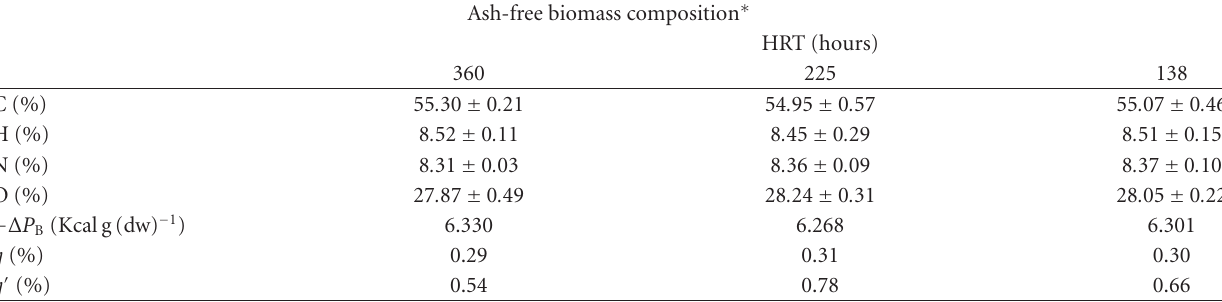
Table 2: Elemental biomass composition and heat of combustion of ash-free biomasses of R. palustris 42OL grown under SCR, at three di ff erent HRTs. The conversion e ffi ciencies ( η and η (cid:4) ) have been reported as well. Cells were harvested when the semisteady state condition was